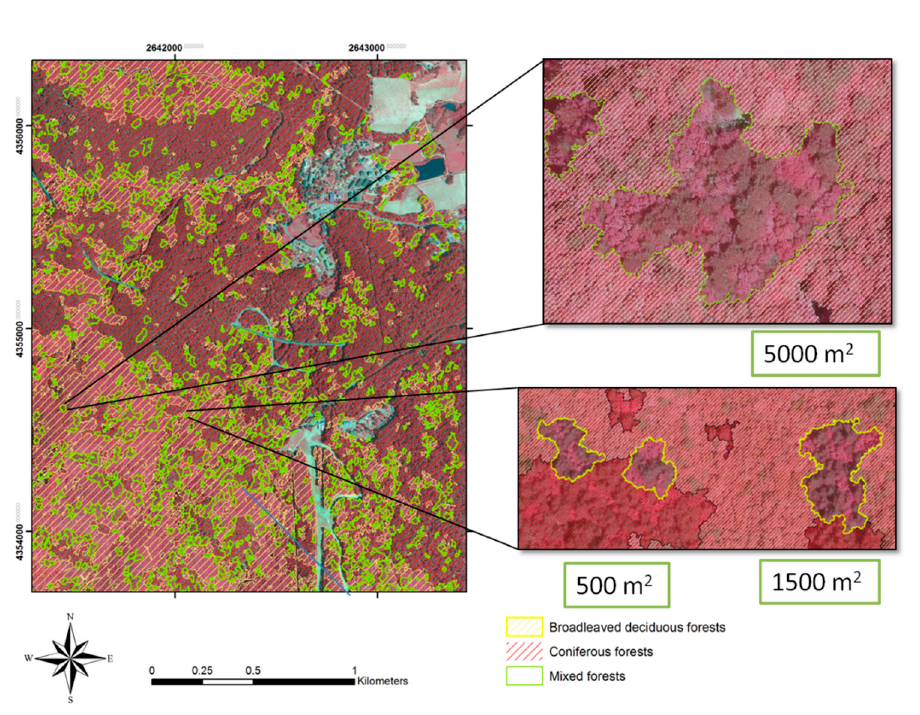
Figure 6. Examples of patches of different size assigned to “mixed forest” class (EPSG 3004). Table 5. Area covered by forest classes.